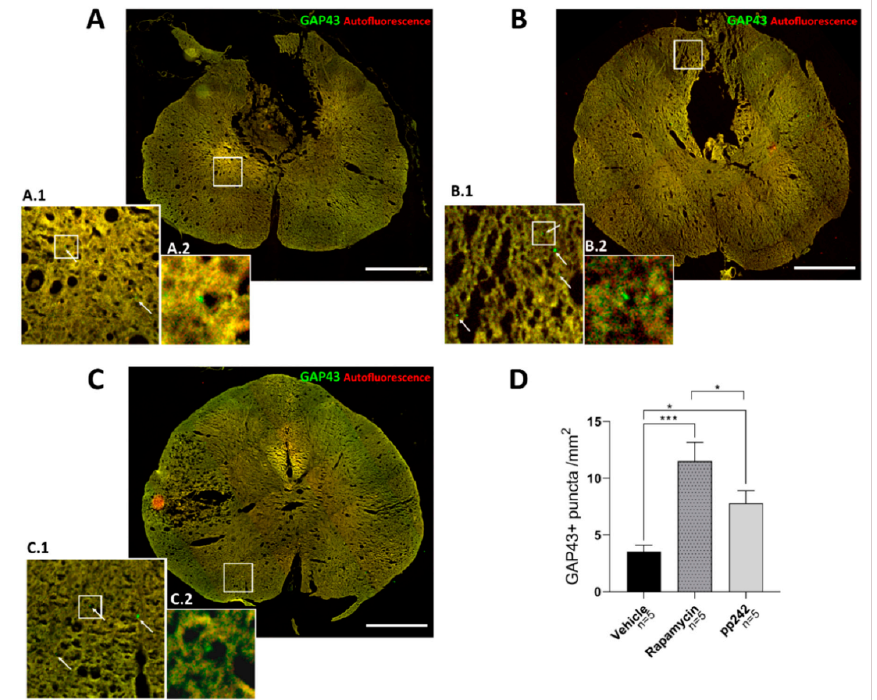
Figure 4. Inhibition of mTOR pathway by RAPA ( B ) leads to greater axonal sprouting assessed by the number of GAP43 + puncta compared to inhibition by pp242 ( C ) and controls ( A ), as shown in the graph ( D ). Scale bars: 500 µ m; A.1, B.1, and C.1 images are 1:5 magnifications of corresponding areas of the spinal cord, whereas A.2, B.2, and C.2 are 1:4 magnifications of the indicated areas of A.1, B.1, and C.1, respectively. Arrows point to examples of GAP43 + puncta. Data are shown as means + SEM; * p < 0.05, *** p < 0.001.